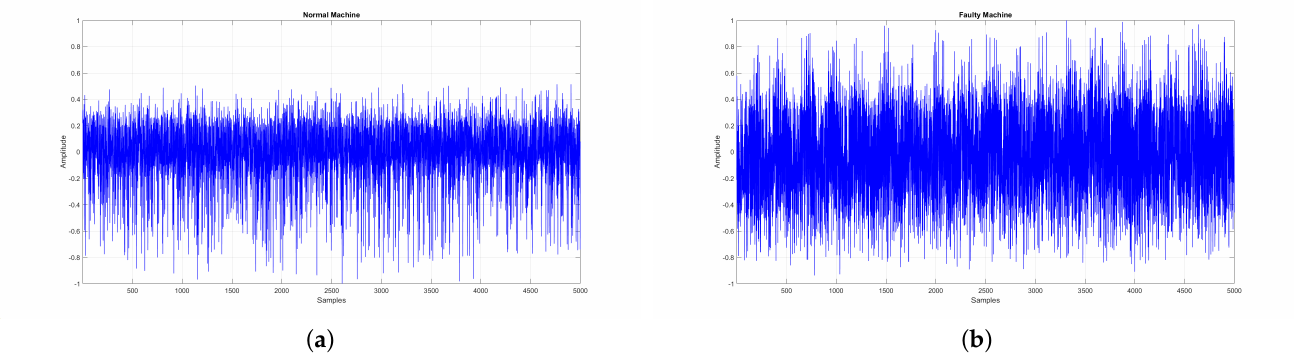
Figure 3. Time Domain Representation of Vibration signal for Normal and Faulty Motor. ( a ) Normal Motor. ( b ) Faulty